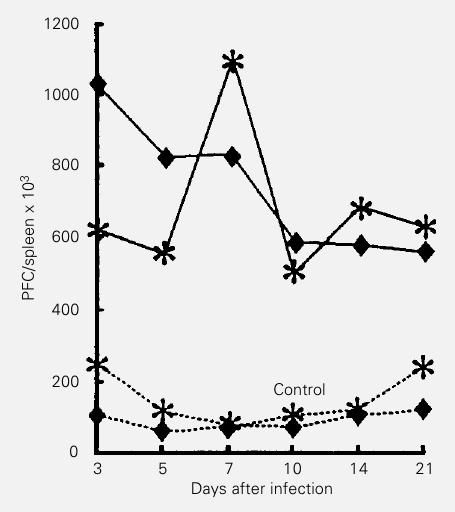
Figure 2 - Number of plaque- forming cells (PFC) of IgM ( ¢ ) and IgA ( ] ) isotypes in the spleen of control mice and mice infected with 1.2 x 10 8 cells/ml of Y. enterocolitica O:3. Results are reported as the average val- ues of plaque-forming cells/ spleen for 5 mice in each group. The standard deviation was al- ways less than 25% of the ob- served